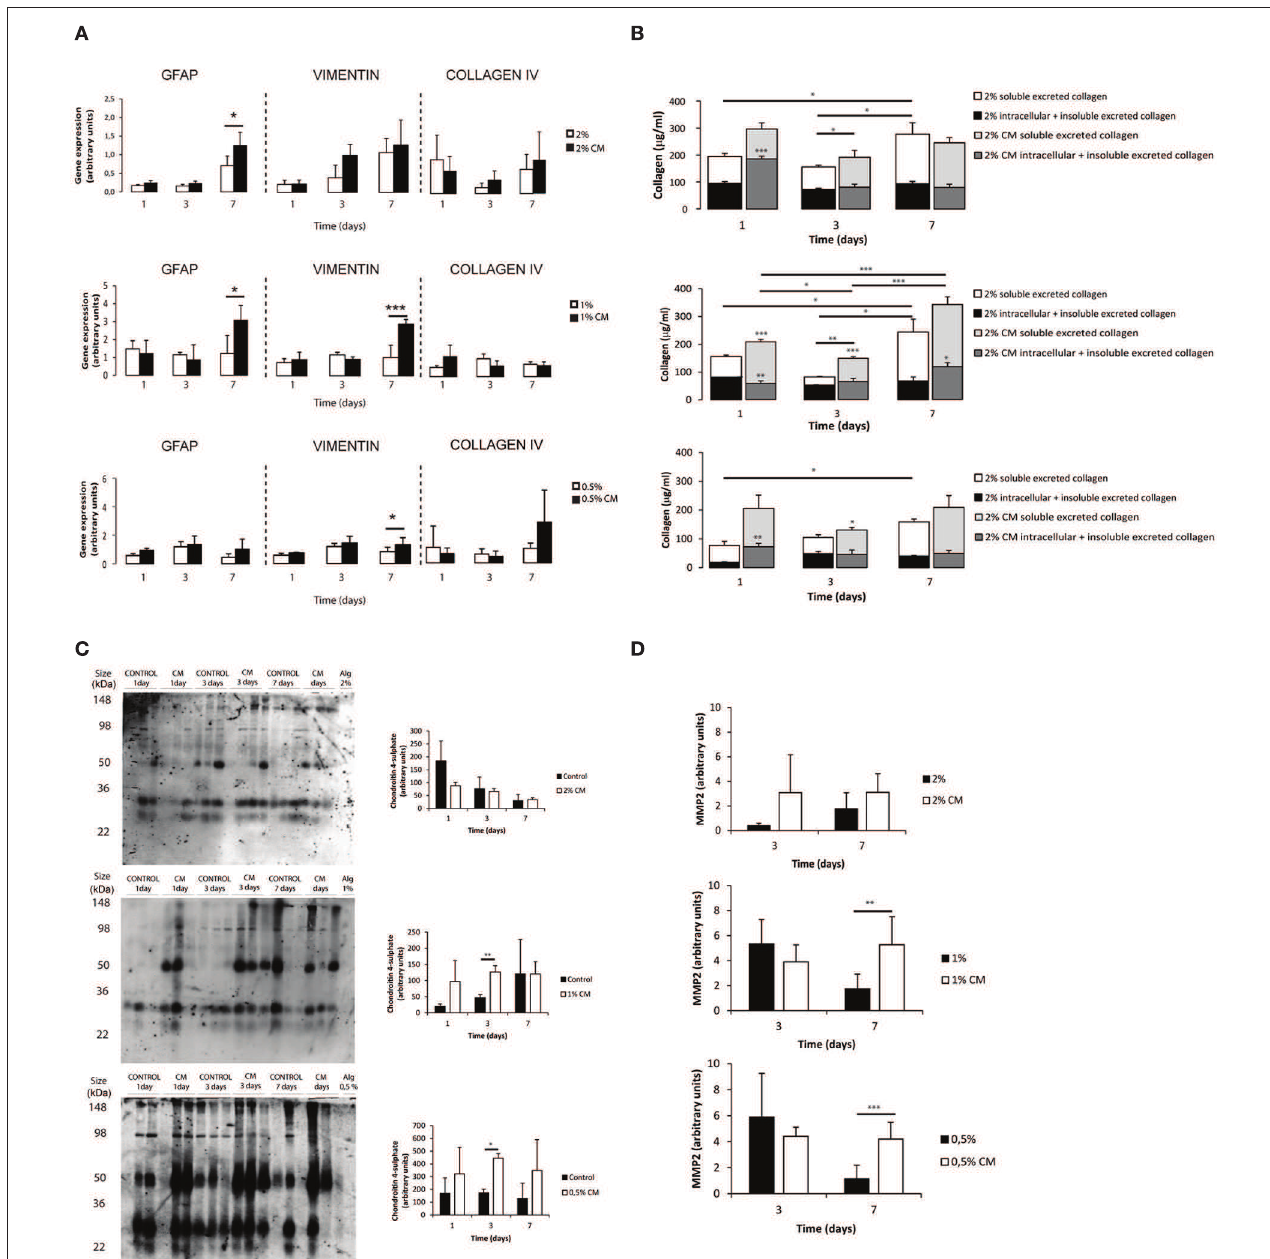
FIGURE 3 | Phenotype and matrix production of 3D seeded astrocytes. Results are shown as mean ± standard deviation; asterisks represent statistical differences, * p < 0.05 , ** p < 0.01 , *** p < 0.001 (A) mRNA levels for Gfap, Vimentin and Collagen IV of astrocytes seeded within alginate discs; (B) Collagen quantification at 1, 3, and 7 days of culture. Collagen was measured in the supernatant (collagen excreted to the culture medium) and in the alginate disc (Deposited and cytoplasmic collagen) ( n = 3 ), regarding statistical analysis asterisks alone represent differences between of one component (excreted or intracellular collagen) and the control, asterisks above the bars with guidance line represent differences between total collagen levels; (C) Quantification of chondroitin 4 sulfate (C4S) at 1, 3, and 7 days of culture. For each time point 3 samples from independent experiments were loaded in the gel. Quantification graphs refer to whole lane ( n = 3 ); (D) MMP-2 activity at 3 and 7 days of culture ( n = 4